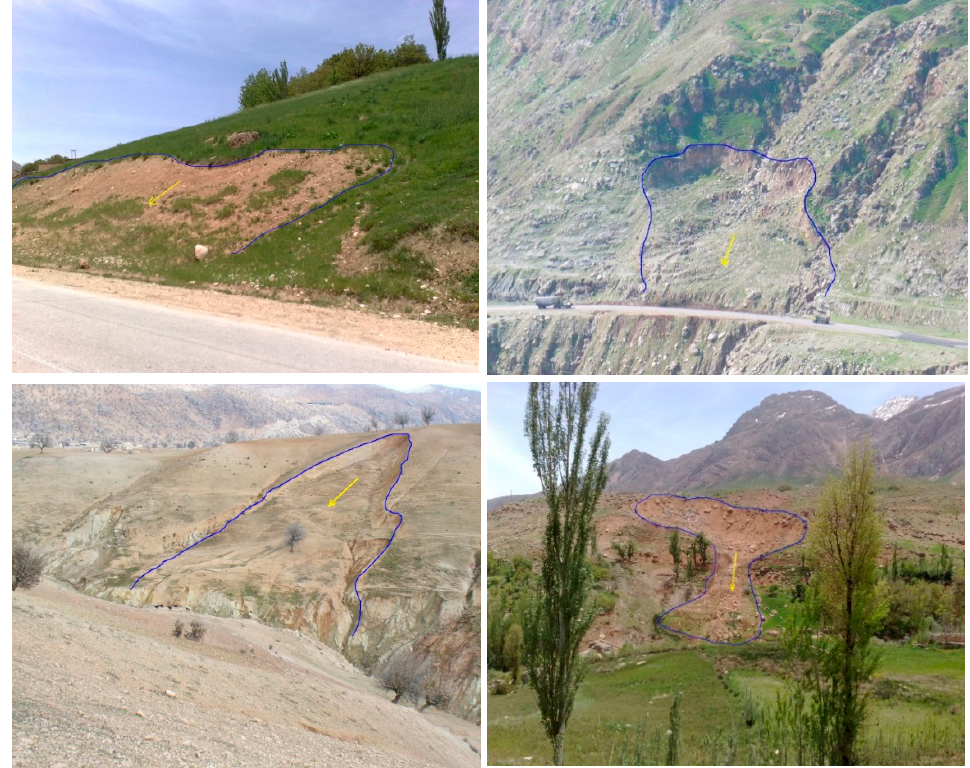
Figure 2. Some recent landslides in the Sarkhoon watershed.